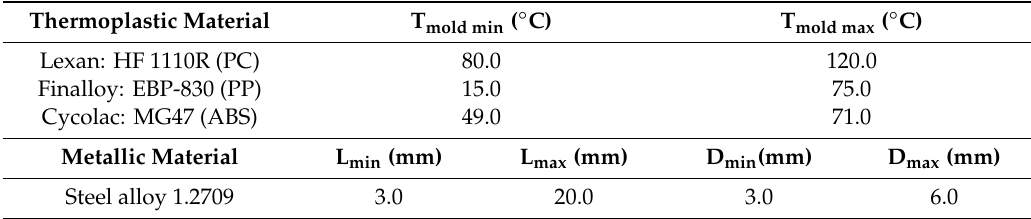
Table 4. Constraint values of the optimization problem